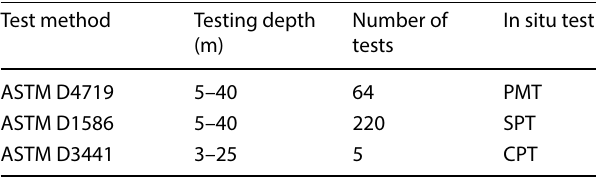
Table. 1 Type and number of in situ testing performed in along the TML2 [33 and